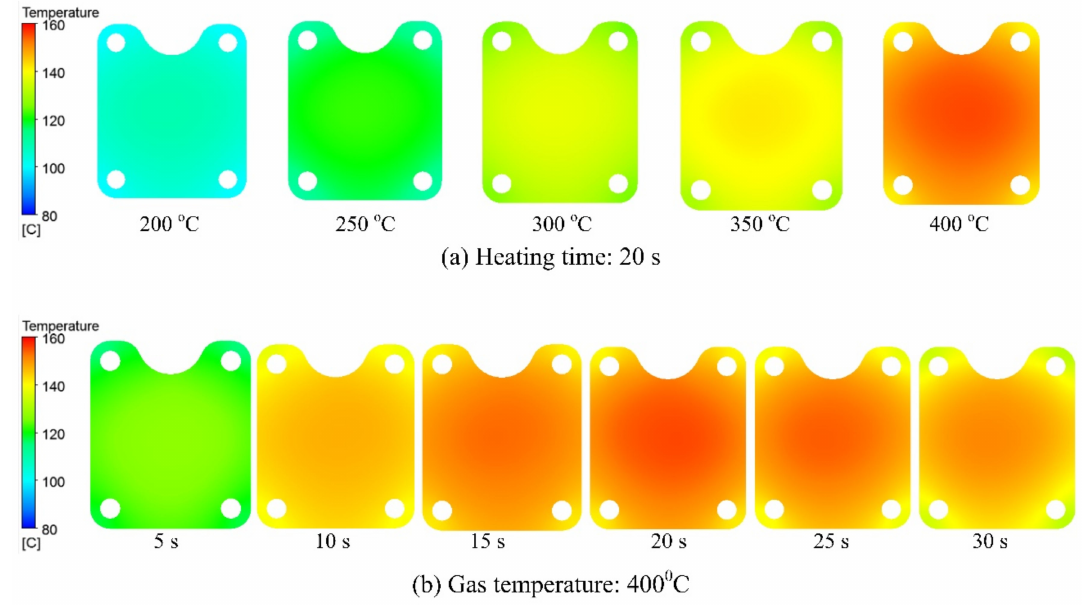
Figure 12. Simulation result of temperature distribution at the insert surface with changes in ( a ) heating source from 200 to 400 ◦ C and ( b ) heating time from 5 to 30